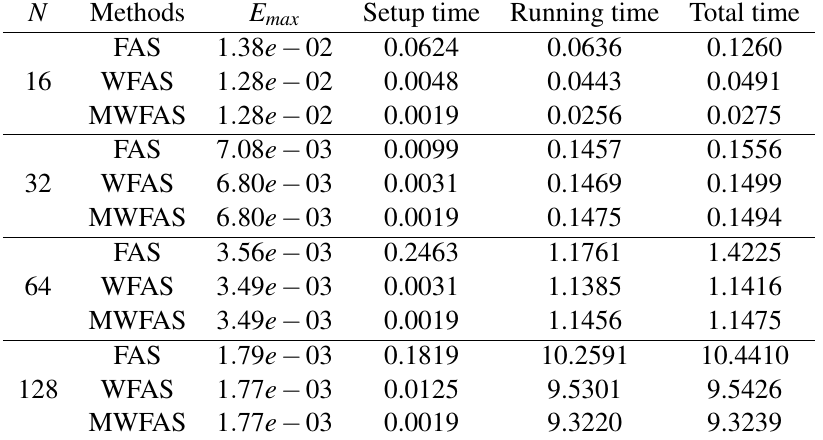
Table 4 Maximum error and CPU time (in seconds) of the methods of test problem 5.2.